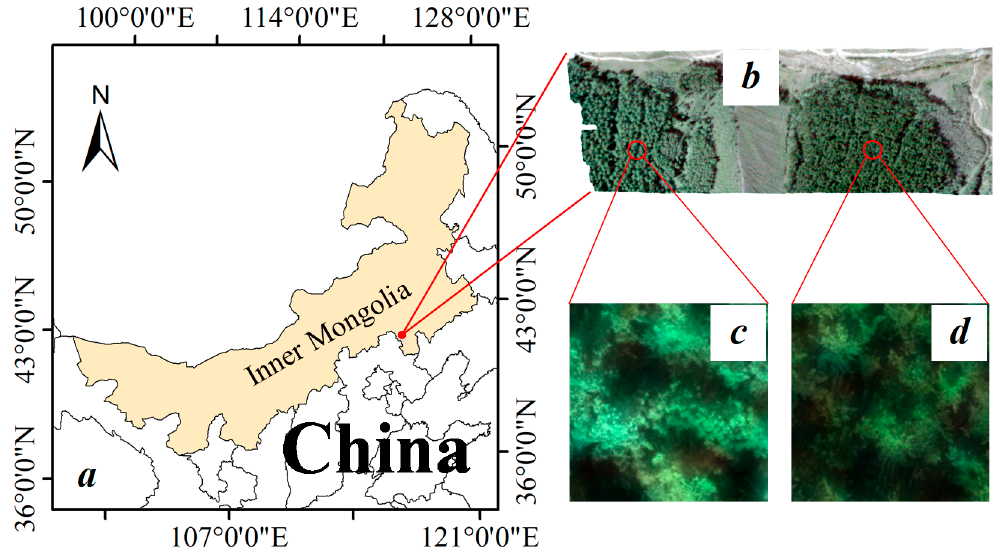
Figure 1. Study site location ( a ) and hyperspectral data (R: 650 nm, G: 562 nm, B: 470 nm) by a UAV imaging spectrometer ( b ) with detailed canopies of Pinus ( c ) and Larix ( d ).